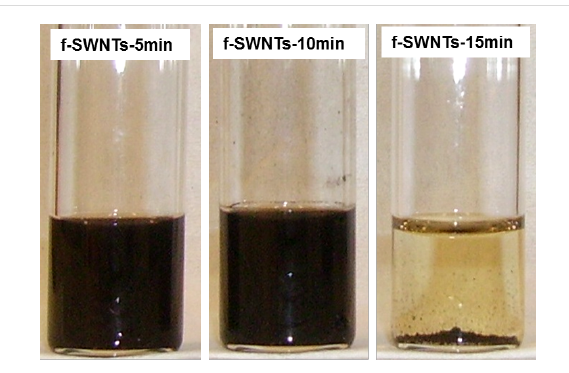
Figure 1: Photographs of f-SWNT-5min, f-SWNT-10min and f-SWNT- 15min dispersed in THF 1 week after their preparation.